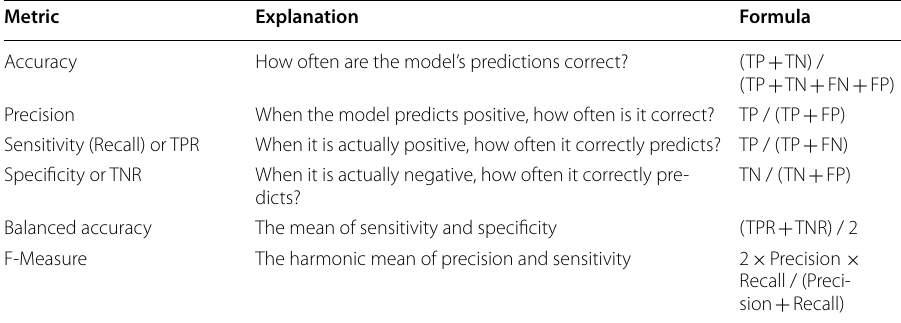
Table 5 Classification performance metrics Metric